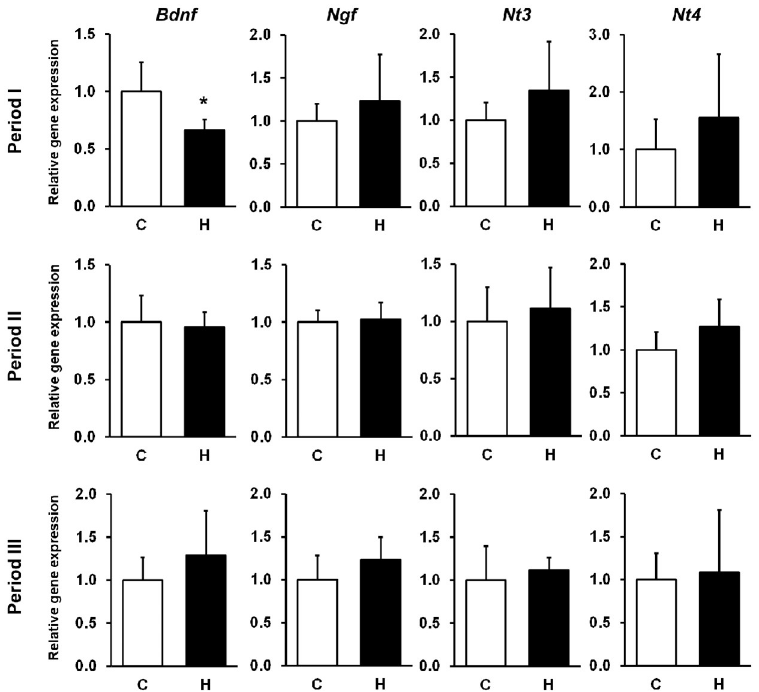
Fig 2. Hippocampal mRNA levels of NFs. Each mRNA was quantified by qPCR. The results are expressed as the ratio of the relative intensity of levels of gene expression to Actb . Bdnf gene expression was reduced in the Period I with HFCS. Period I: C, n = 5; H, n = 6, Period II: C, n = 8; H, n = 7, Period III: C, n = 7; H, n = 6. C, Control group; H, HFCS group; data are presented as mean ± SD. � p < 0.05.